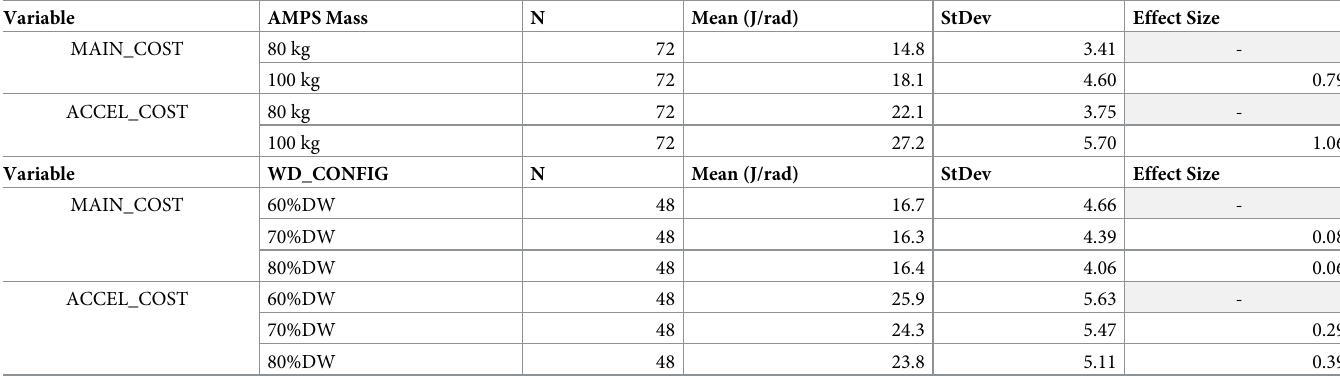
Table 9. Fixed-wheel turn: Cost differences.